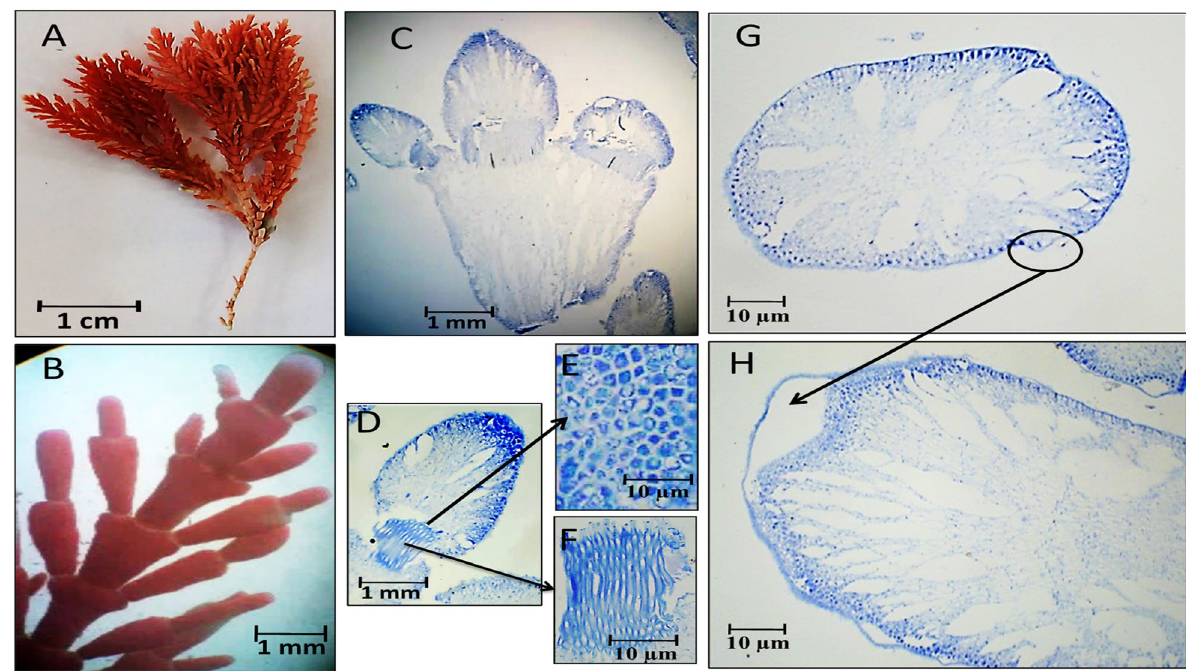
Fig. 3 Morphological and anatomical description of C. officinalis thallus during winter 2019. A Habit view of thallus, B Magnification of the thallus frond, C L.S. in thallus showing genicula and intergenicula tiers, D L. S. through Magnification of mature geniculum and intergenicula, E Mature geniculum with polygonal cells, F Cross-section through intergeniculum, G and H Cross-section through intergeniculum